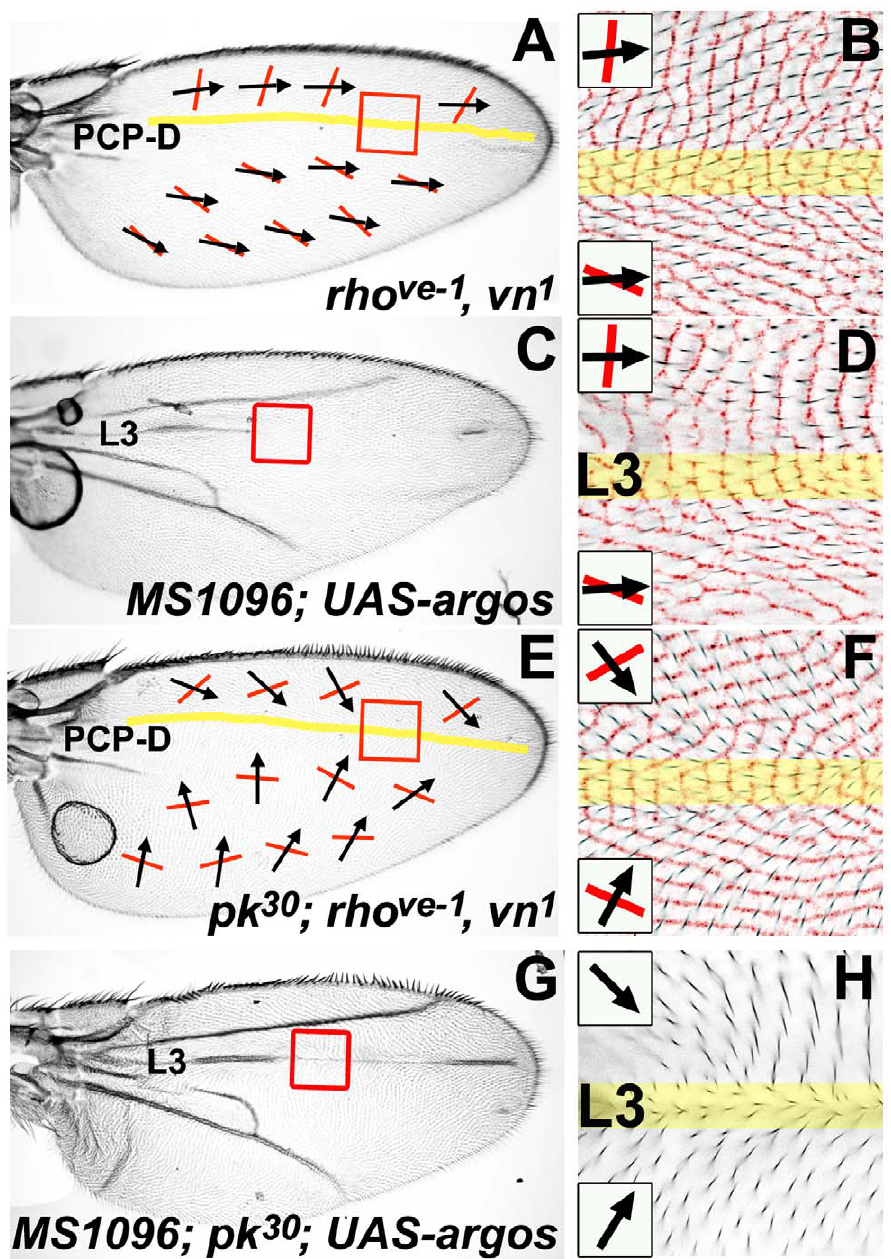
Figure 2. A PCP discontinuity (PCP-D) on the Drosophila wing. All micrographs are of the female dorsal wing surface. Black arrows indicate local hair polarity; red lines indicate local ridge orientation. Yellow shading represents the approximate location of a discontinuity in PCP (the PCP-D). Panels B, D, and F show light micrographs of hair polarity overlaid on an inverted and colorized (red) CRM image of ridge orientation in the same region. (A) rho ve-1 , vn 1 homozygous wing. (B) Detail of rho ve-1 , vn 1 homozygous wing (red-boxed region in (A)). (C) MS1096-gal4 ; UAS-argos wing. (D) Detail of MS1096-gal4 ; UAS-argos wing (red-boxed region in (C)). (E) pk pk30 ; rho ve-1 , vn 1 homozygous wing. (F) Detail of pk pk30 ; rho ve-1 , vn 1 wing (red- boxed region in (E)). (G) MS1096-gal4 ; pk pk30 /pk pk30 ; UAS-argos wing. (H) Detail of MS1096-gal4 ; pk pk30 /pk pk30 ; UAS-argos wing (red-boxed region in (G)) showing hair polarity. doi:10.1371/journal.pgen.1001305.g002 The phenotypes generated using the VDRC ft and ds RNAi mapped ridge orientation on wings homozygous for the amorphic fj D1 allele. Homozygous fj D1 wings have altered shape, but hair lines are unlikely to result from off-target RNAi activity as they polarity is disrupted in only a small proximal region (red shaded phenocopy the established mutant phenotype of these genes. In oval in Figure 3J), the same region affected by uniform ft or ds addition, we were able to reproduce these phenotypes using knockdown. We found that posterior ridges on fj D1 homozygous independent ft (JF03245) and ds (JF02842) RNAi lines from the wings also have a more A-P orientation than wild-type (Figure 3L), TRiP project (Transgenic RNAi Project, Harvard Medical School) but anterior ridges are unchanged (Figure 3K). in combination with the same Gal4 driver (data not shown).